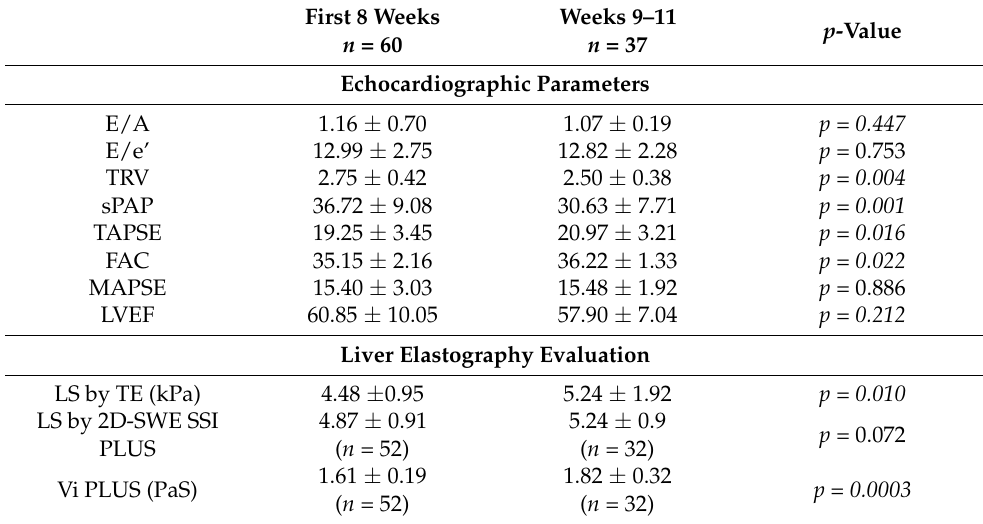
Table 3. Comparison between subjects according to the time elapsed from the COVID-19 diagnosis until TTE and liver